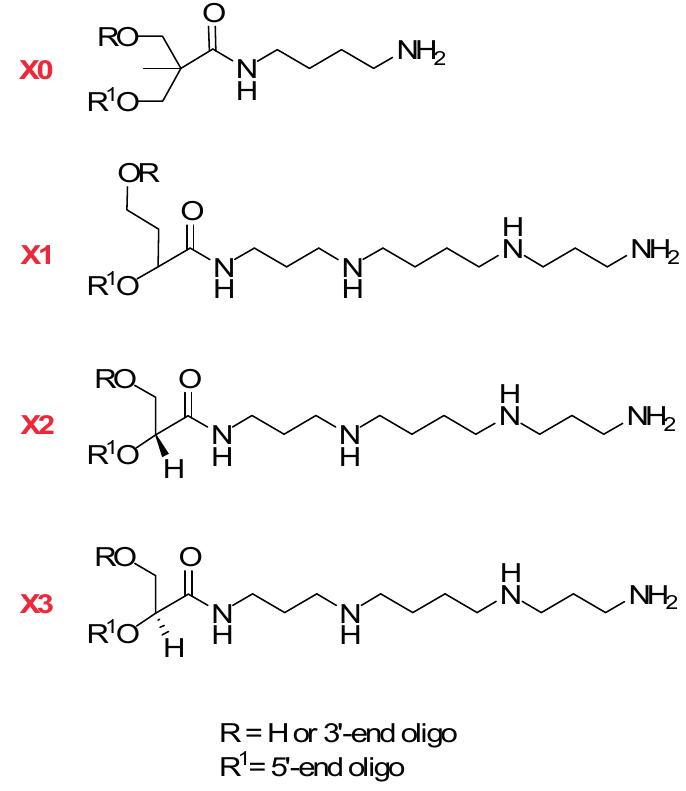
Figure 2. Non-nucleosidic polyamino-nucleoside analogues units in oligodeoxyribonucleotide